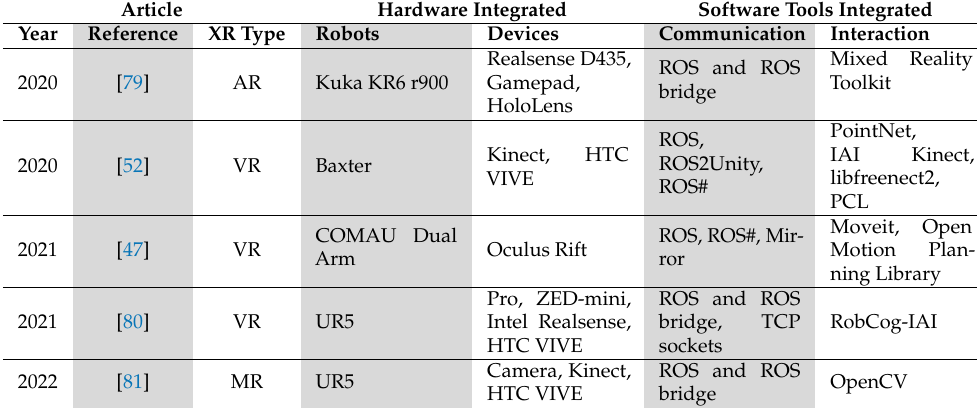
Table 7. Articles presenting XR solutions for the teleoperation of industrial robots using game